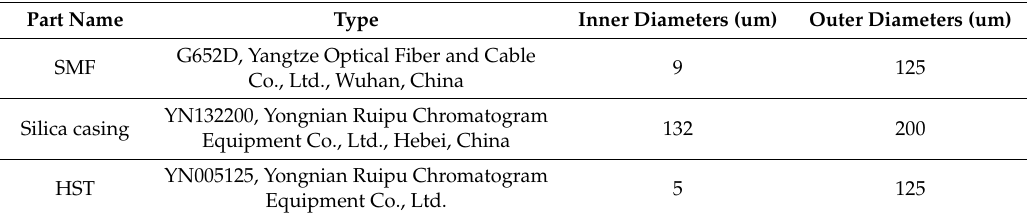
Table 1. The specs of parts used in the sensor.